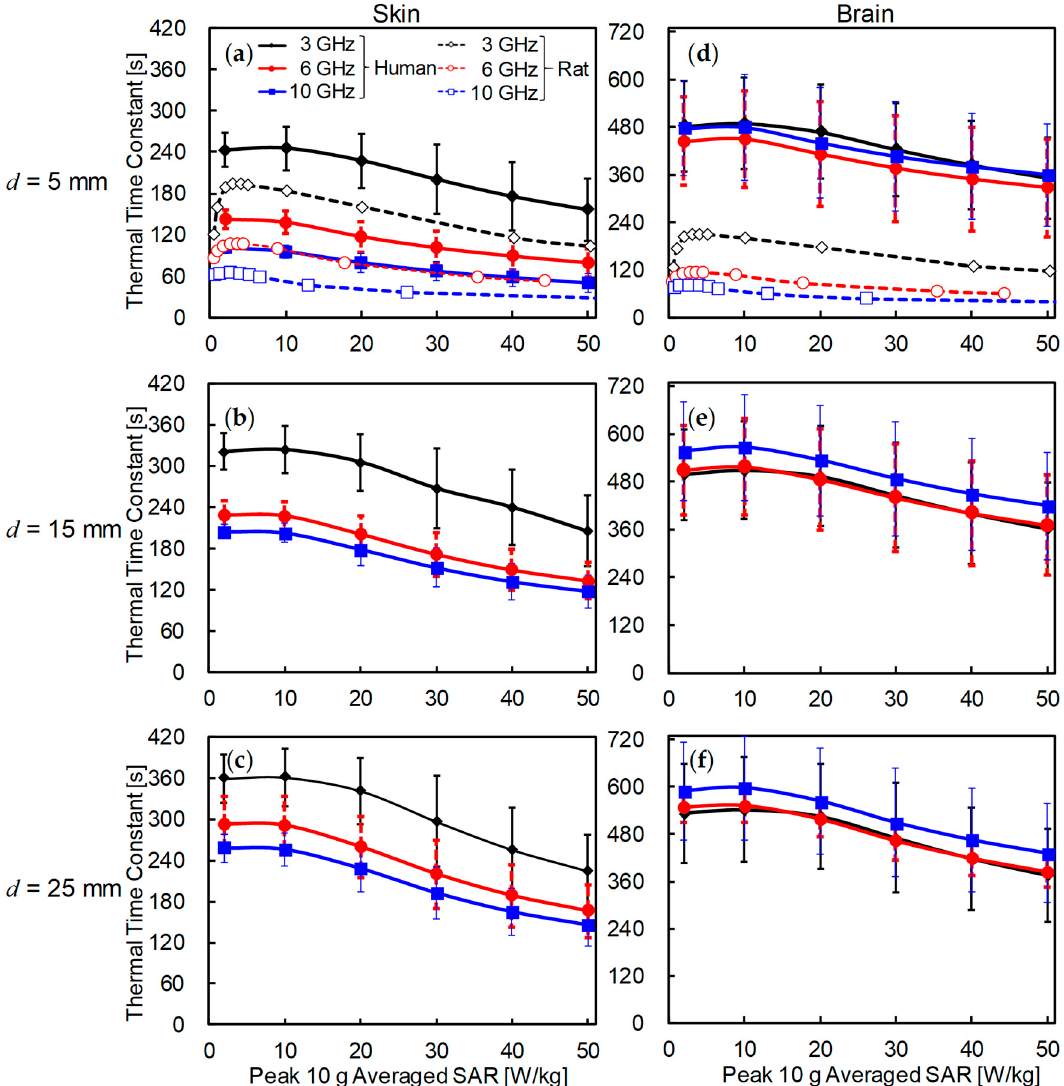
Figure 7. Thermal time constants of ( a – c ) skin ( τ in Equation (9)) and ( d – f ) brain ( τ + τ D in Equation (9)) in human models for each peak SAR averaged over 10-g tissue. The distances between the skin surface and the dipole antenna d were set to ( a , d ) 5, ( b , e ) 15, and ( c , f ) 25 mm. Each point represents the average value and error bar showing the standard deviation ( n = 4). For comparison, the temperature elevation of rat brain tissue was also plotted at the 5-mm distance.